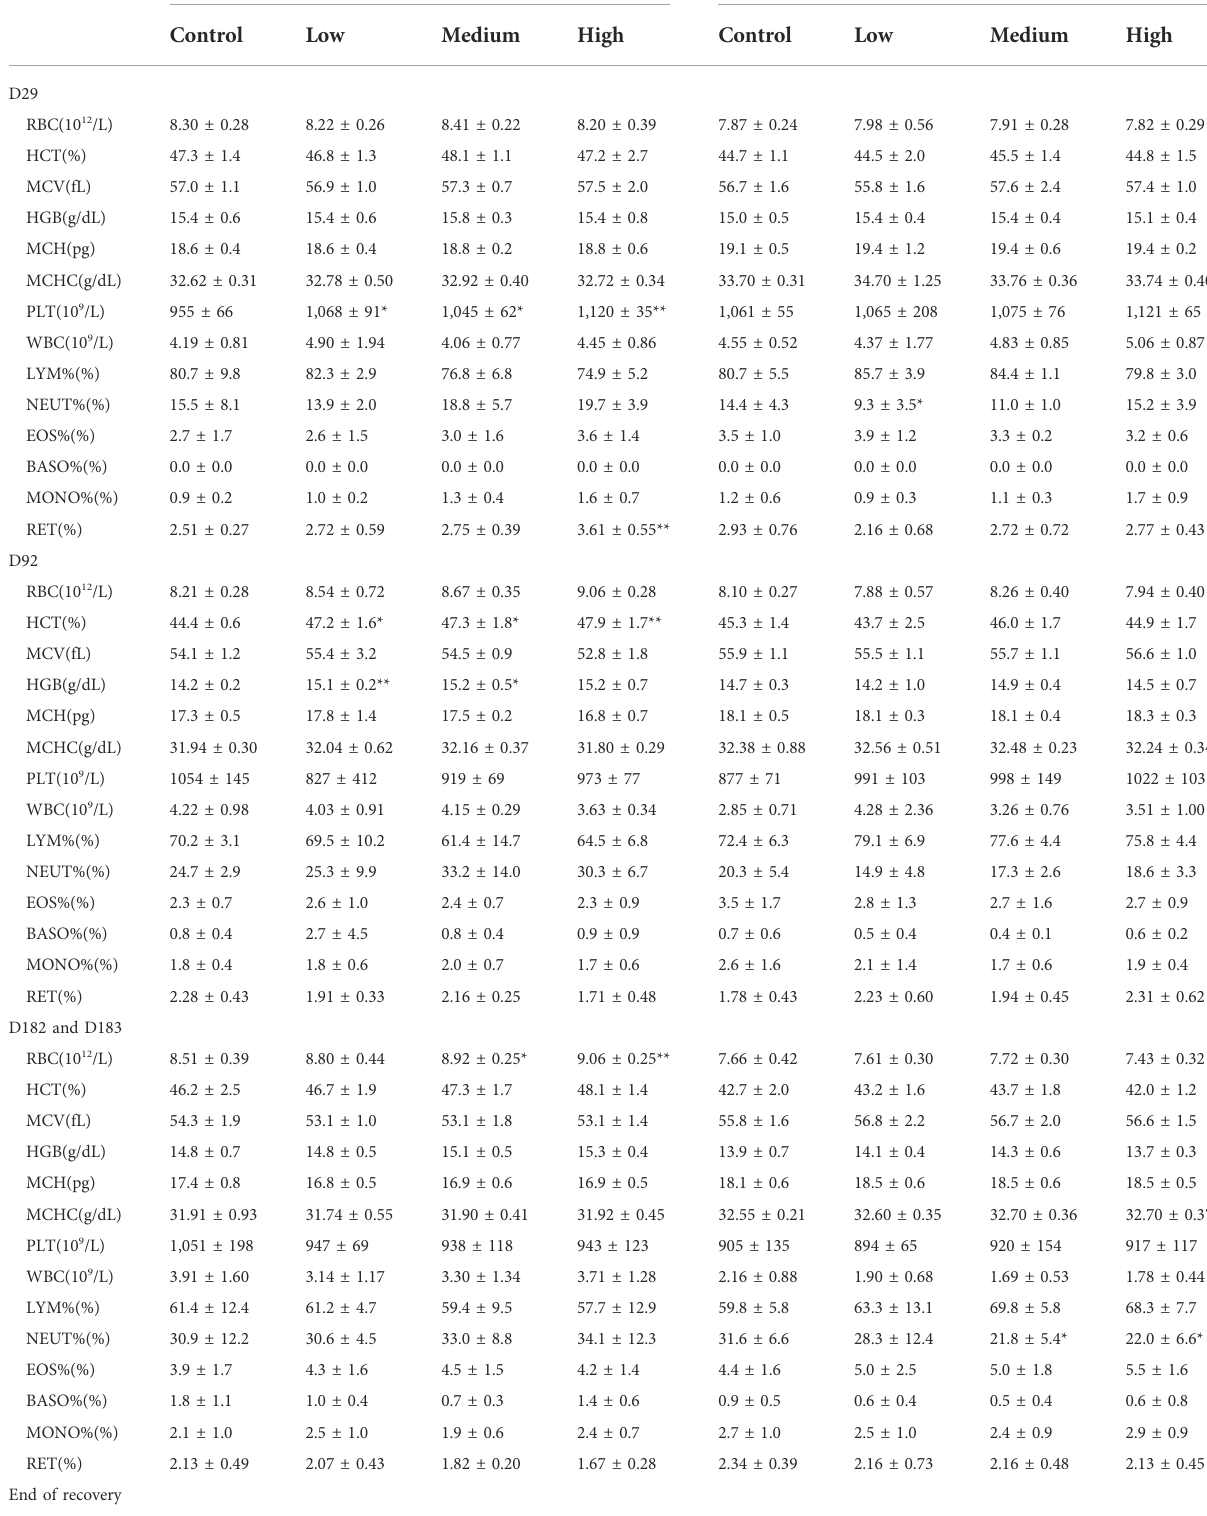
TABLE 2 Hematological parameters in rats treated with DLTD. Parameter Male Female Control Low Medium High Control Low Medium